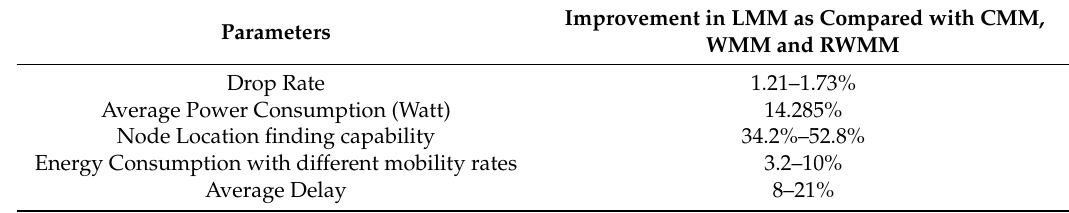
Table 5. LMM-improvement over other competing mobility